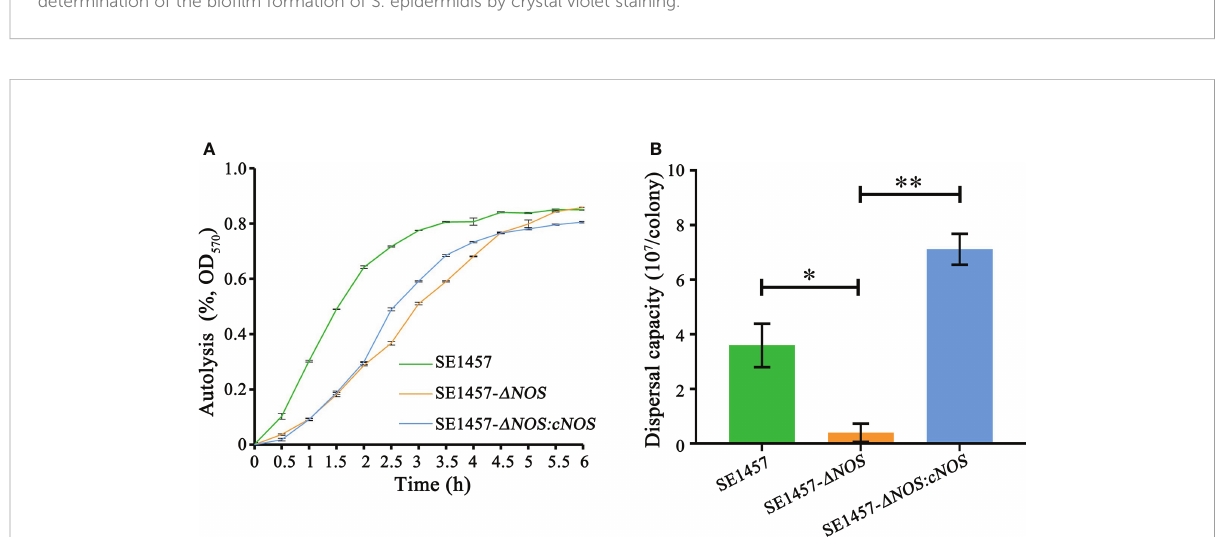
FIGURE 5 Determination of the bacterial autolysis induced by 0.01% Triton X-100 and bacterial bio fi lm dispersal capacity. (A) Experimental data are presented as the mean ± SD obtained from three independent experiments. SE1457 , SE1457- D NOS and SE1457- D NOS:cNOS are the wild strain, deletion strain and complement strain, respectively. (B) Experimental data are presented as the mean ± SD obtained from three independent experiments. SE1457 , SE1457- D NOS and SE1457- D NOS:cNOS are the wild strain, deletion strain and complement strain, respectively. * p < 0.05, ** p < 0.01.